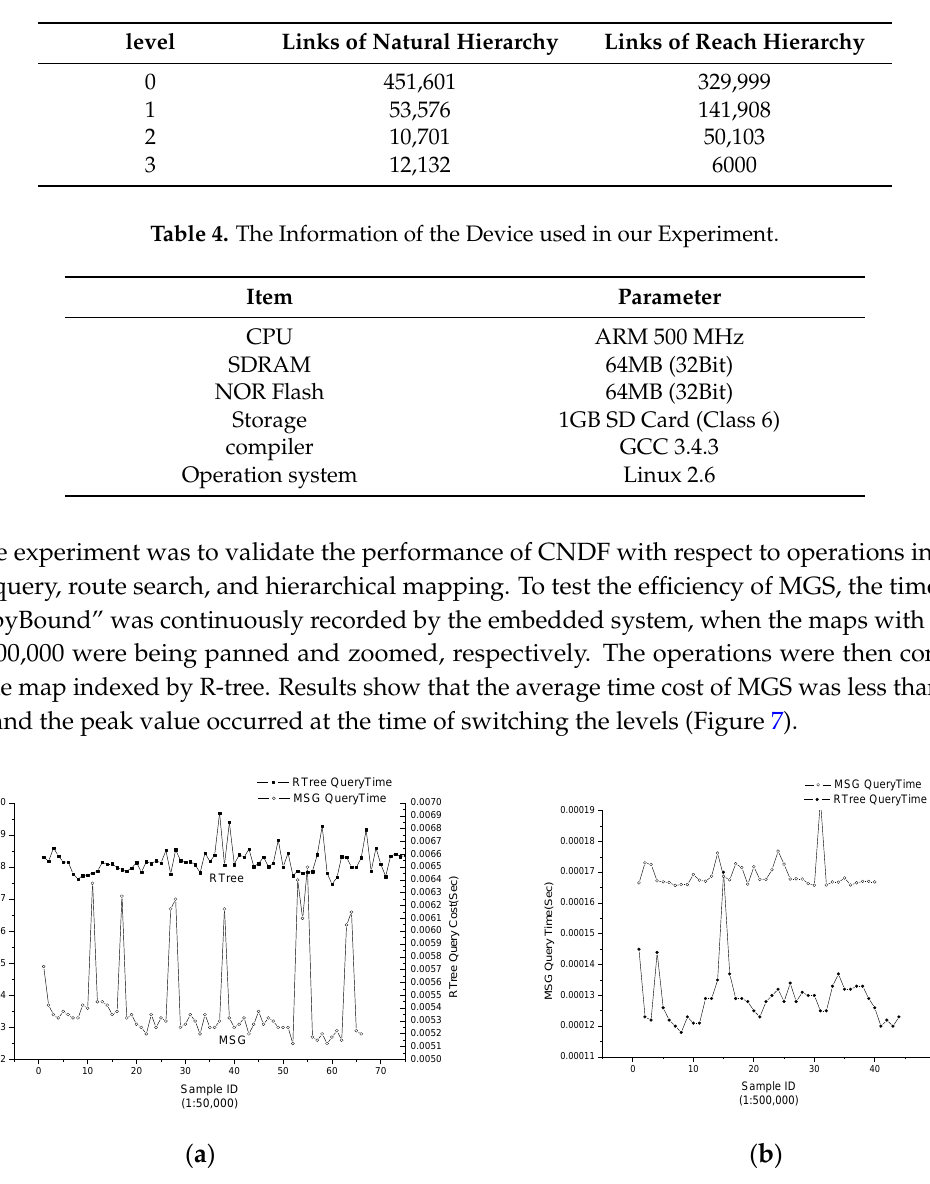
Table 3. The Hierarchy of the Navigation Map for East China.